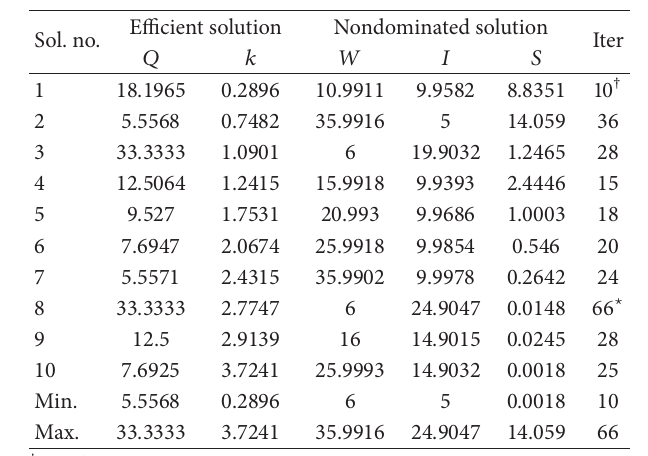
Table 5: Tradeoff solutions of Item 4 generated by successive approximation.